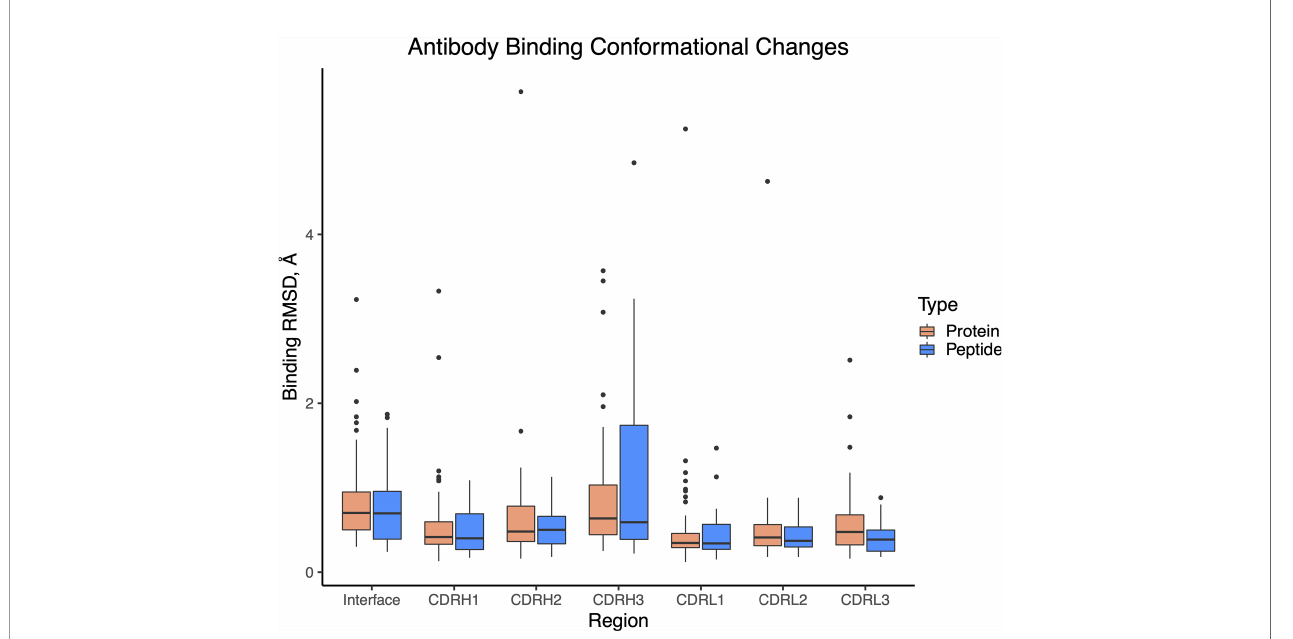
FIGURE 8 | Antibody binding conformational changes in antibody-antigen and antibody-peptide complexes. Comparison of unbound and bound antibody structures was performed for antibody-peptide (N = 32) and antibody-antigen (N = 54) structures. Calculated values are backbone atom root-mean-square distances, using interface residues proximal (< 10 Å) of the bound antigen (Interface), or individual CDR loops.